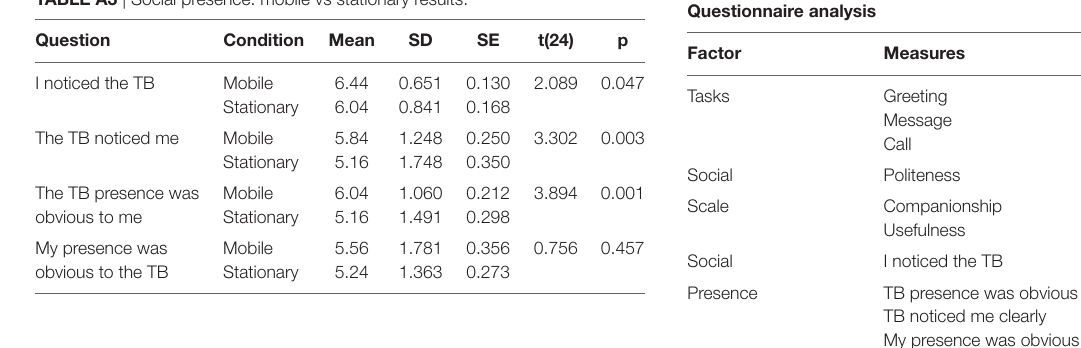
TaBle a4 | Task context: social vs neutral results.